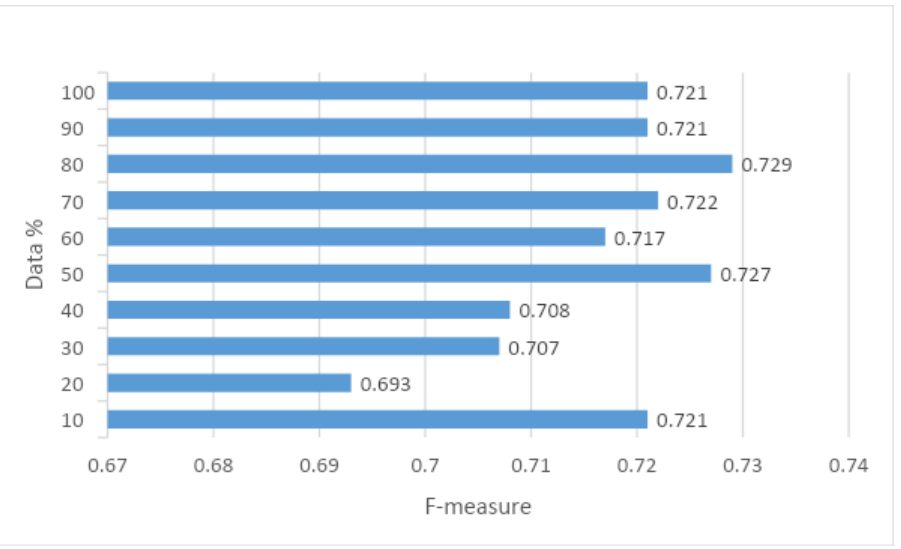
Figure 4. F ‐ measure for Naïve Bayesian with a random subset. Figure 4. F-measure for Naïve Bayesian with a random subset.